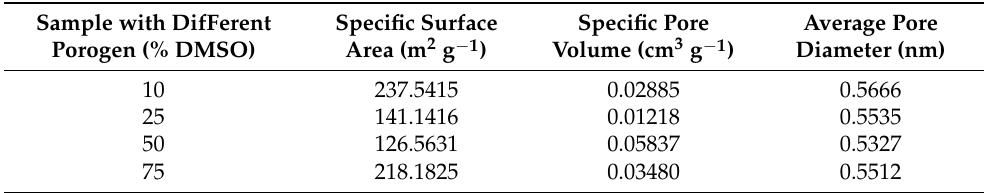
Table 3. BET specific surface area, specific pore volume, and average pore diameter for different porogenic solvent concentrations.